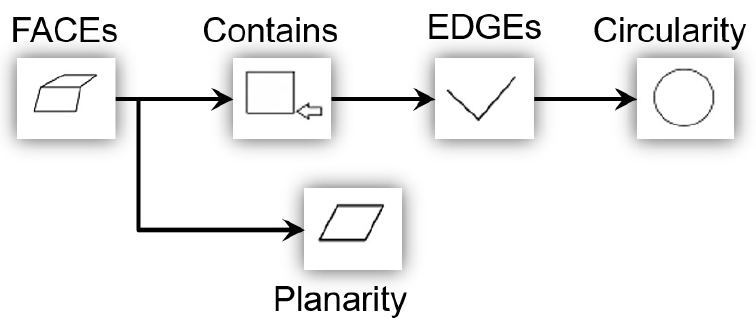
Figure 13. Example of search graph as built in the Graphic User